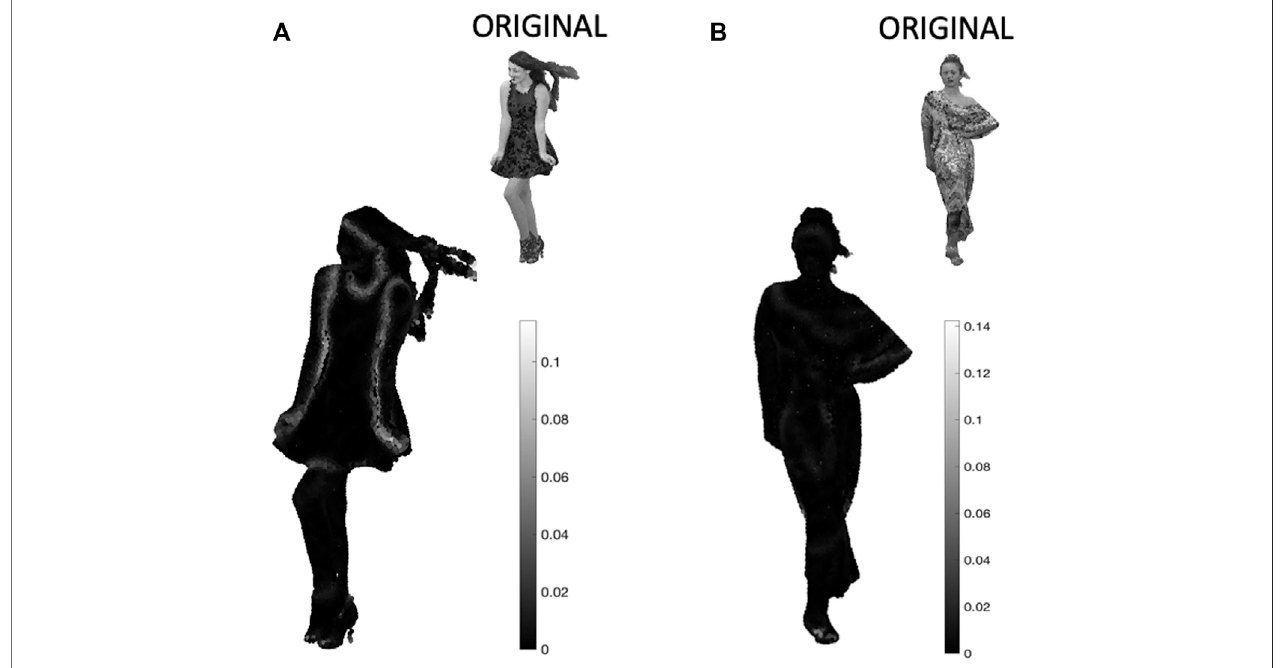
FIGURE10| MAHFappliedonluminanceimagesfortwopointclouds: (A) redandblackand (B) longdress.Wereporttheoriginalluminanceimagesintheinsetsof each panel. In this case, MAHFs are applied to the luminance s ( p i ). We compute the square module of the MAHF output, which corresponds to r ( p i ).